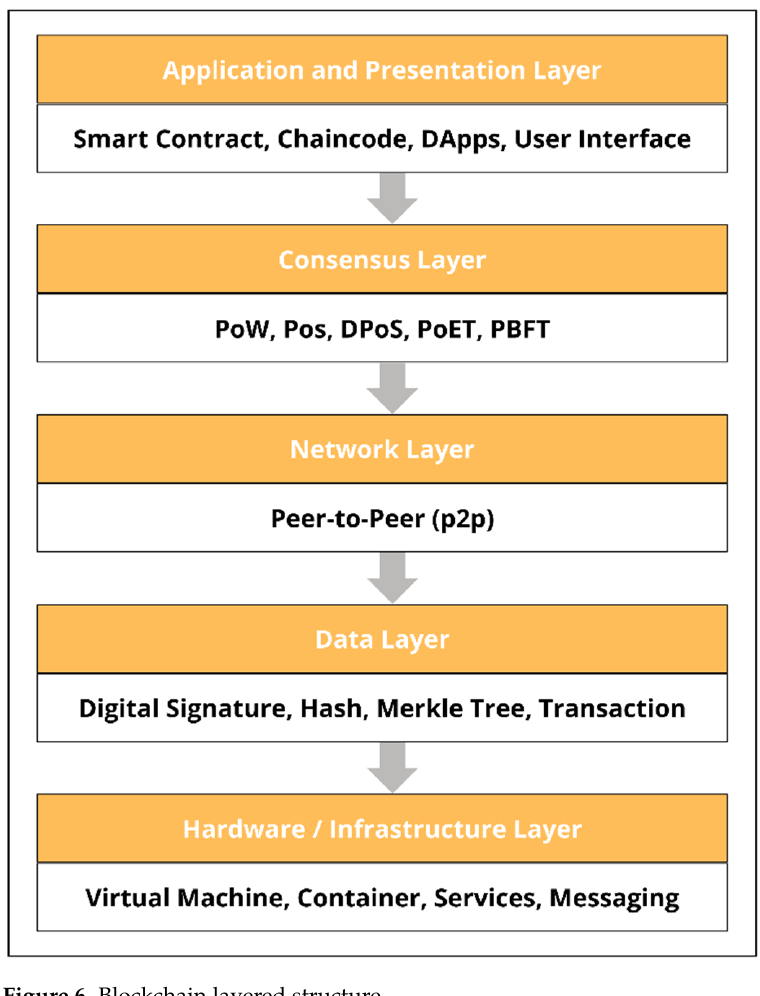
Figure 6. Blockchain layered structure.